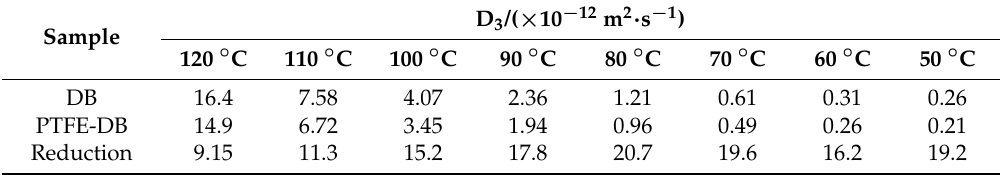
Figure S1. Energy profiles in dynamic simulations. (a) potential; (b) kinetics; (c) nonbond; and (d) total, Figure S2. A typical MSD vs. t curve, Table S1. Mass loss of NG in the two DB propellants. Figure S3. Stress-strain curves of the two propellants, (a) 50 ◦ C; (b) 20 ◦ C; (c) − 40 ◦ C. Figure S4. Crosslinking density (a) and molecular weight between crosslinking points (b). Figure S5. Isothermal TG curves of DB propellant (a) and PTFE-DB propellant (b) at different temperatures. Figure S6. Conversion vs. time curves of DB propellant (a) and PTFE-DB propellant (b) at different